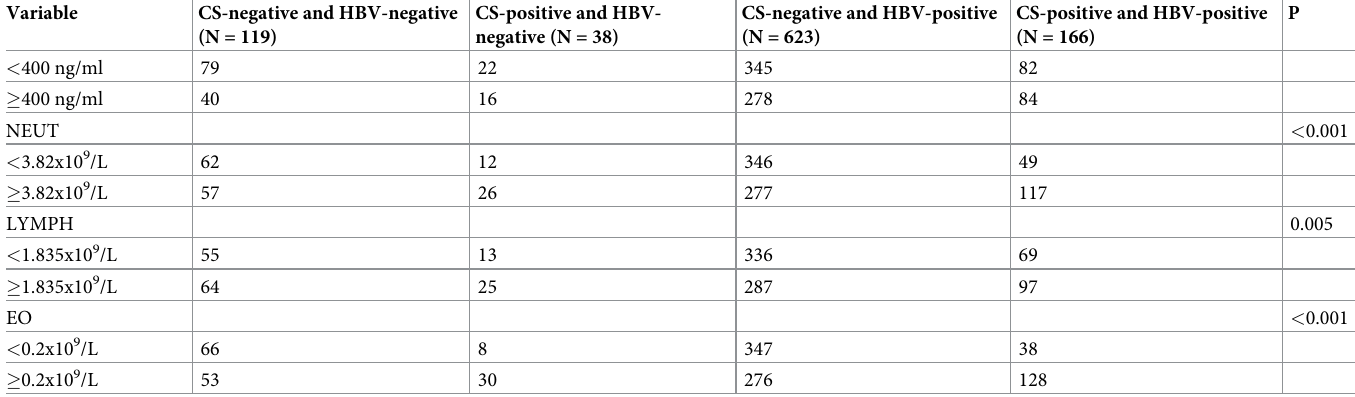
BCLC: Barcelona Clinic Liver Cancer Staging System. MVI: Microvascular invasion. HBsAg: hepatitis B surface antigen. TBil: total bilirubin. AST: aspartate aminotransferase. ALT: alanine aminotransferase. NEUT: absolute neutrophil count. EO: the absolute number of eosinophils. LYMPH: absolute lymphocyte count. CS: Clonorchis sinensis. HBV: Hepatitis B